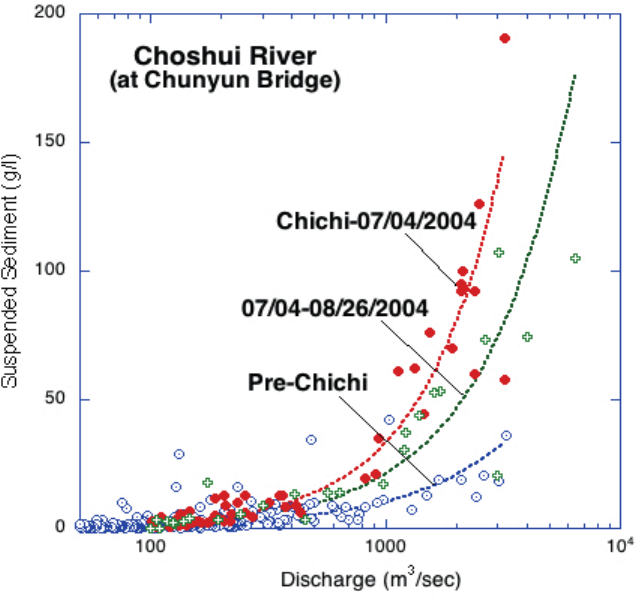
Fig. 6 Pre- and post-Chichi sediment rating curves at Chunyun Bridge (station J). Note both the marked increase in sediment concentrations following the earthquake and the abrupt decrease in concentrations (although still higher than pre-Chichi levels) on 4 July 2004.